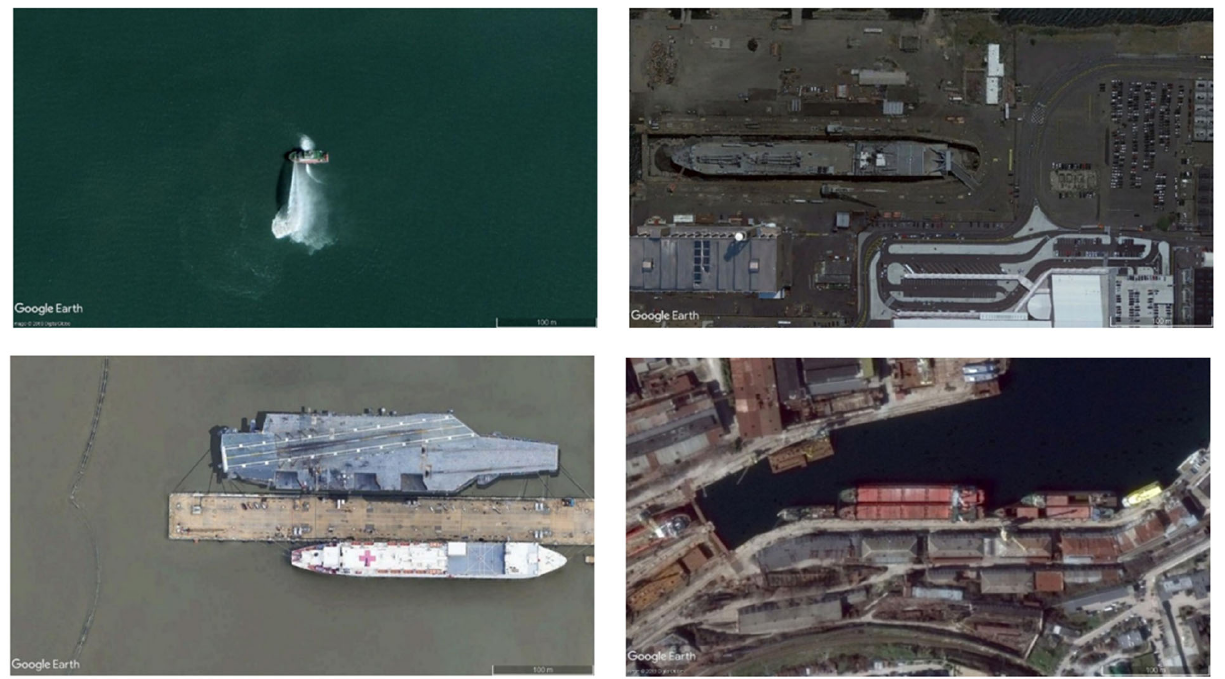
Figure A3. The example images from VHRShips with simple (left column) and complex (right column) background.